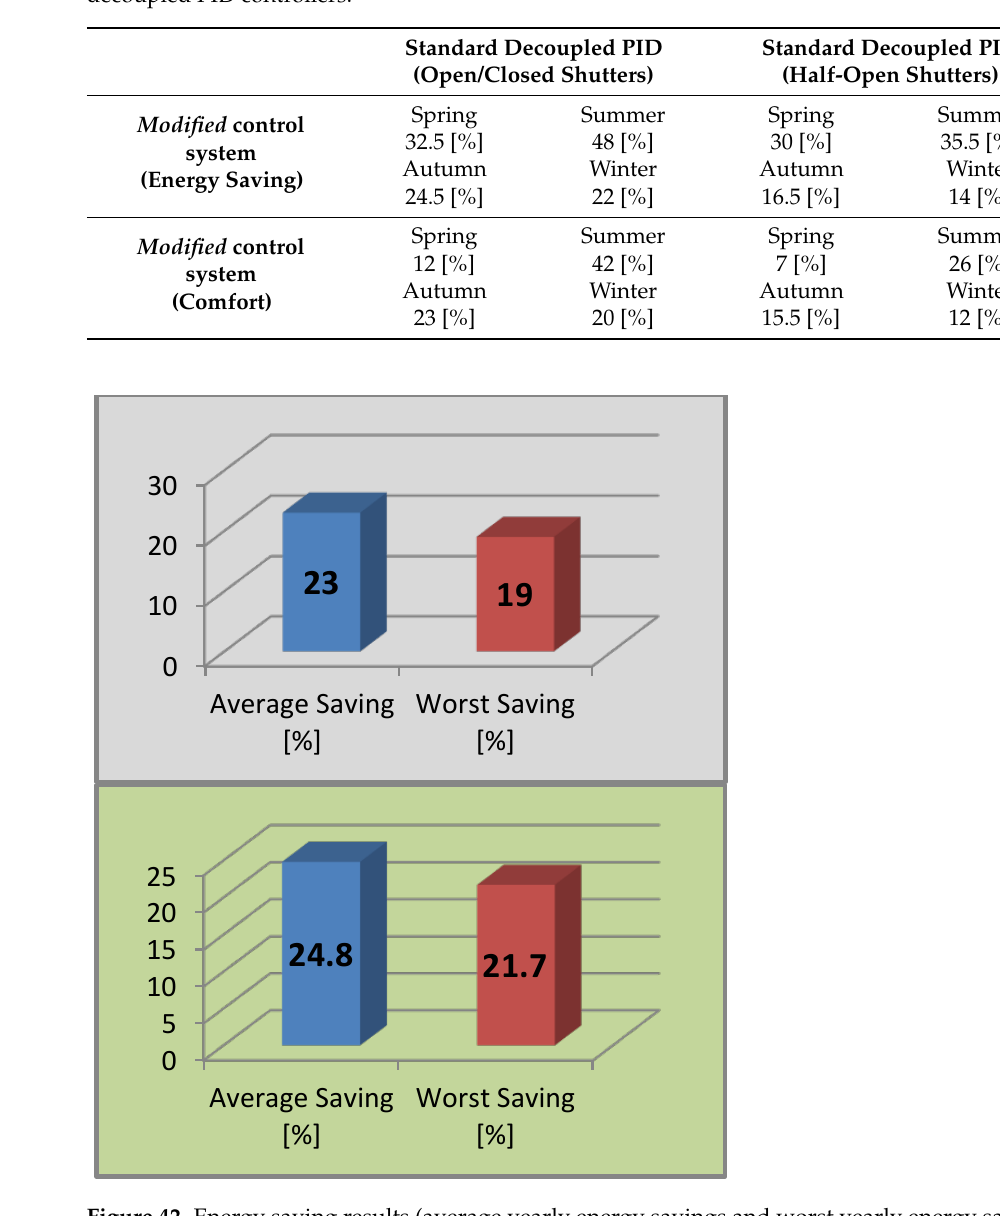
Figure 42. Energy saving results (average yearly energy savings and worst yearly energy savings): initial control system ( top ) and modified control system ( bottom ).